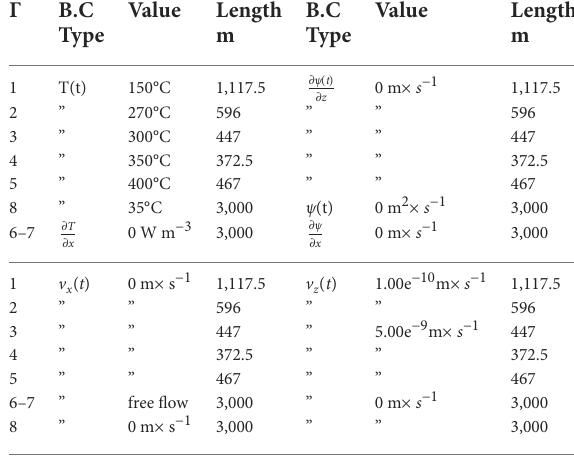
TABLE 2 Initial and boundary conditions applied to the symmetrical